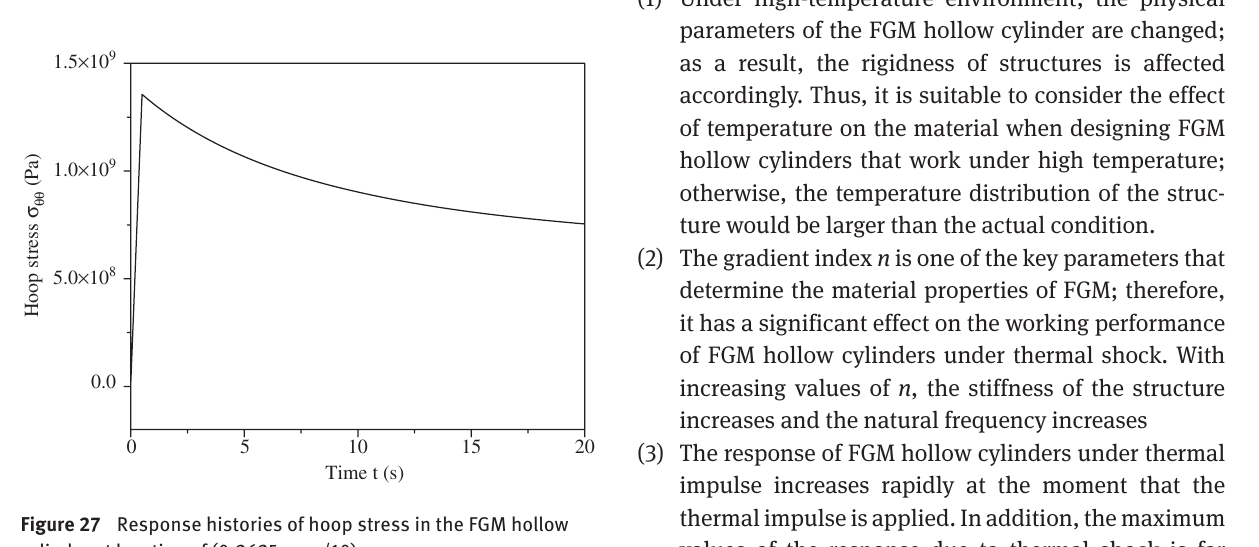
Figure 26 Response histories of radial stress in the FGM hollow cylinder at location of (0.2625 m, π /10).